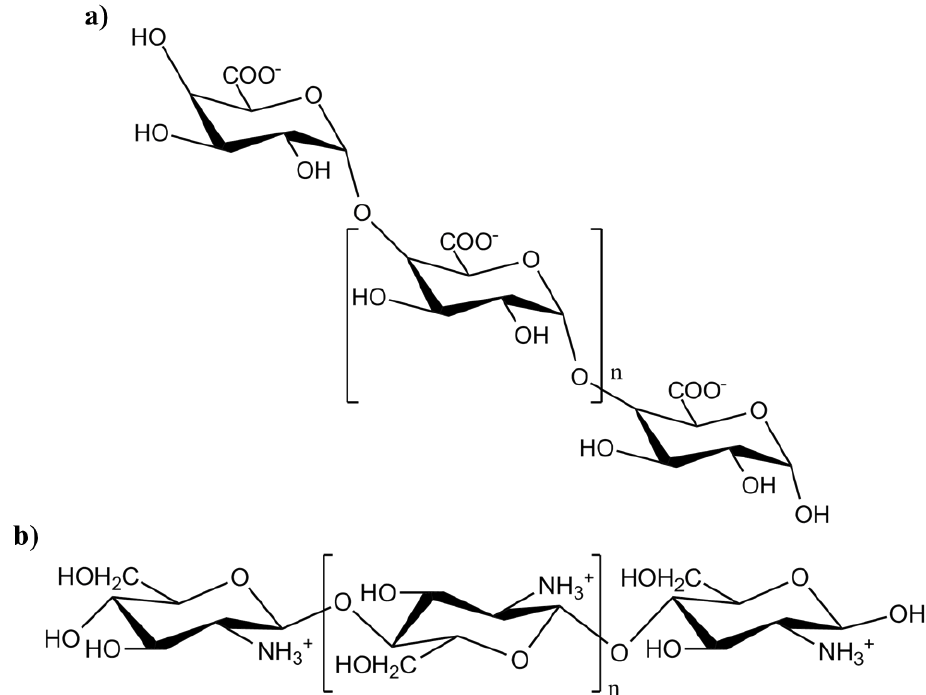
Figure 7. Structures of charged oligosaccharides inducing plant defense-responses. ( a ) The elicitor oligo ( α -1,4) galacturonic acid [97] is formed by the action of polygalacturonase (PG) on plant cell wall pectins; and ( b ) chitosan, an oligomer of β -1,4-linked glucosamine, can also act as an elicitor (Adapted from